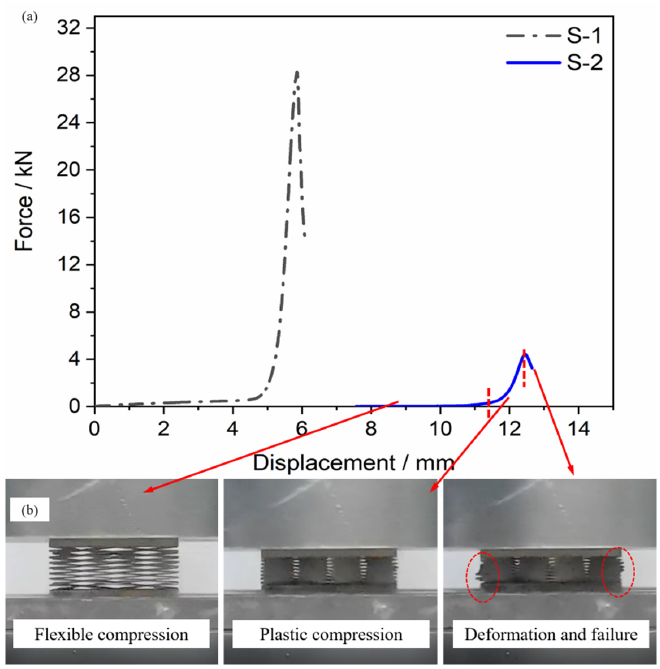
Figure 5. Compressive performance of the BWR lattice: ( a ) Force ‐ Displacement curve of the BWR lattice; ( b ) Compressive process of S ‐ 2. lattice; ( b ) Compressive process of